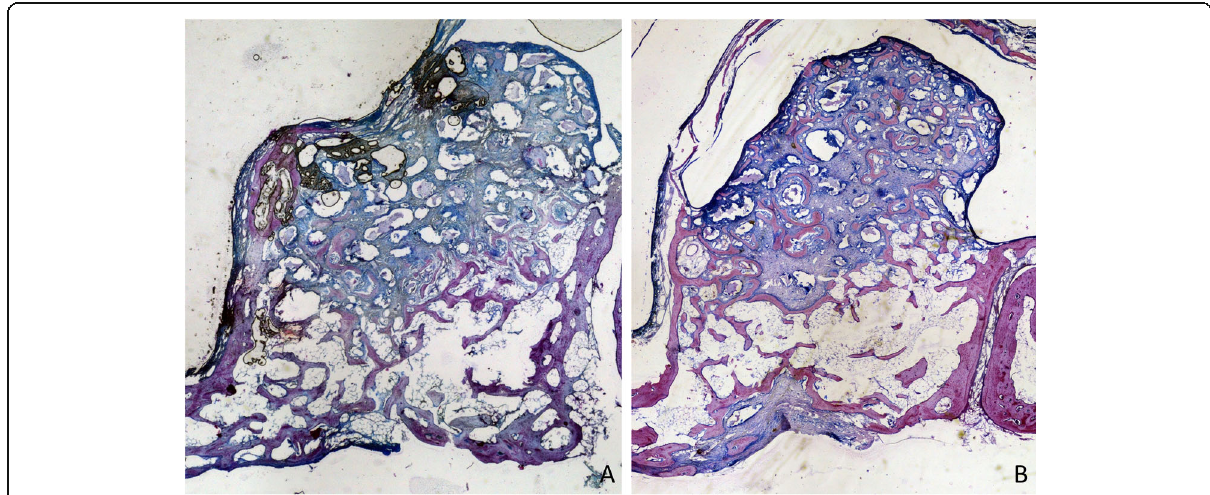
Fig. 5 Photomicrographs of decalcified sections illustrating the healing after 8 weeks. Both at the treated ( a ) and untreated ( b ) sites, the antrostomy was closed in most cases, presenting residual defects of various dimensions in the outer side. New bone was connecting the lateral and medial sinus walls. The middle and sub-mucosa regions were not healed completely yet. Scarlet-acid fuchsine and toluidine blue stain. Images grabbed at × 20